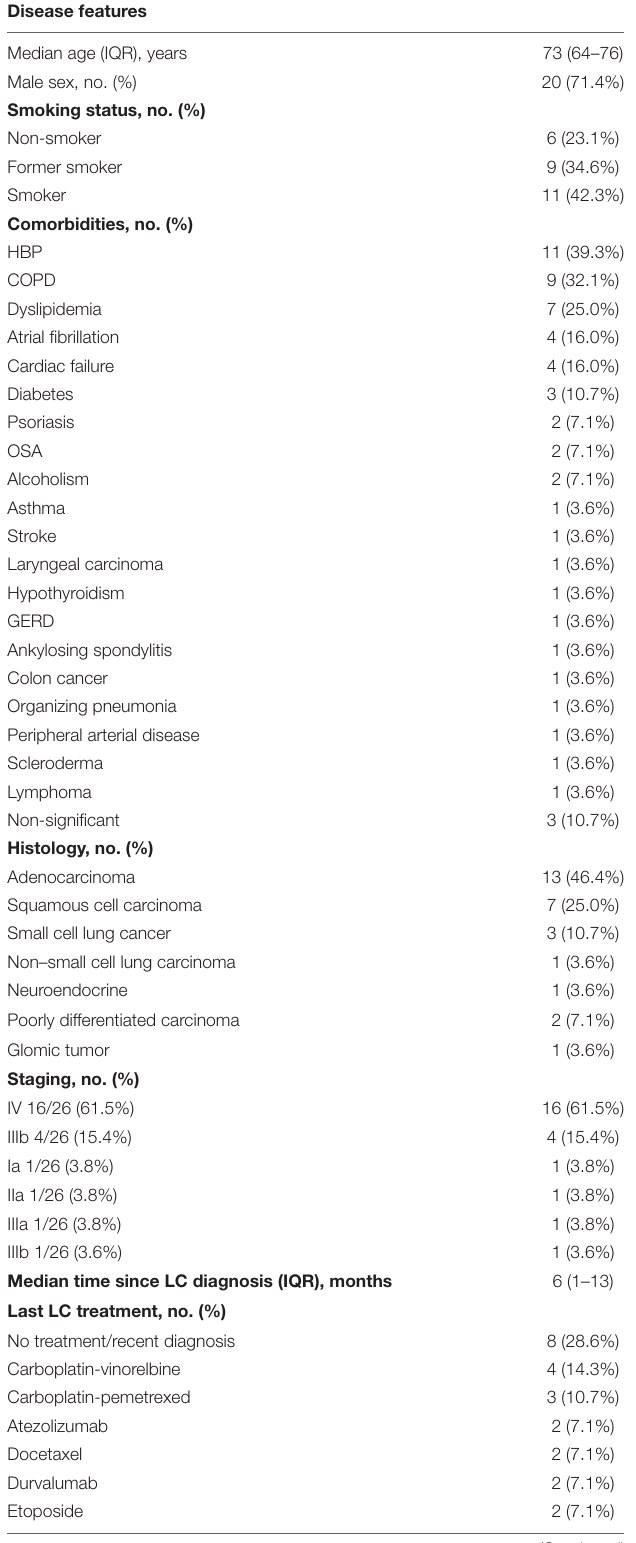
TABLE 1 | Characterization of lung cancer (LC) patients with coronavirus disease 2019 (COVID-19) diagnosis. Disease